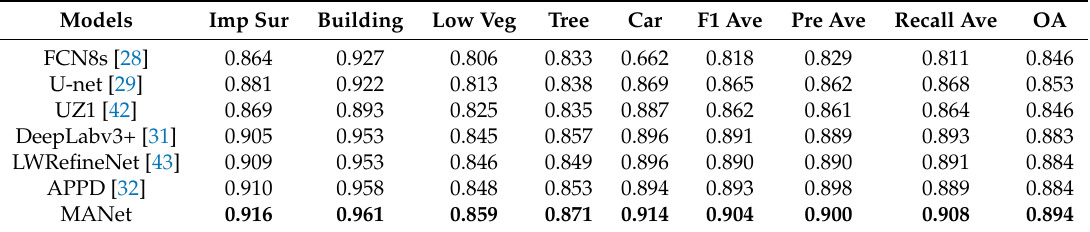
Table 2. The F1 for each category and the average of four metrics for all seven models on the Potsdam